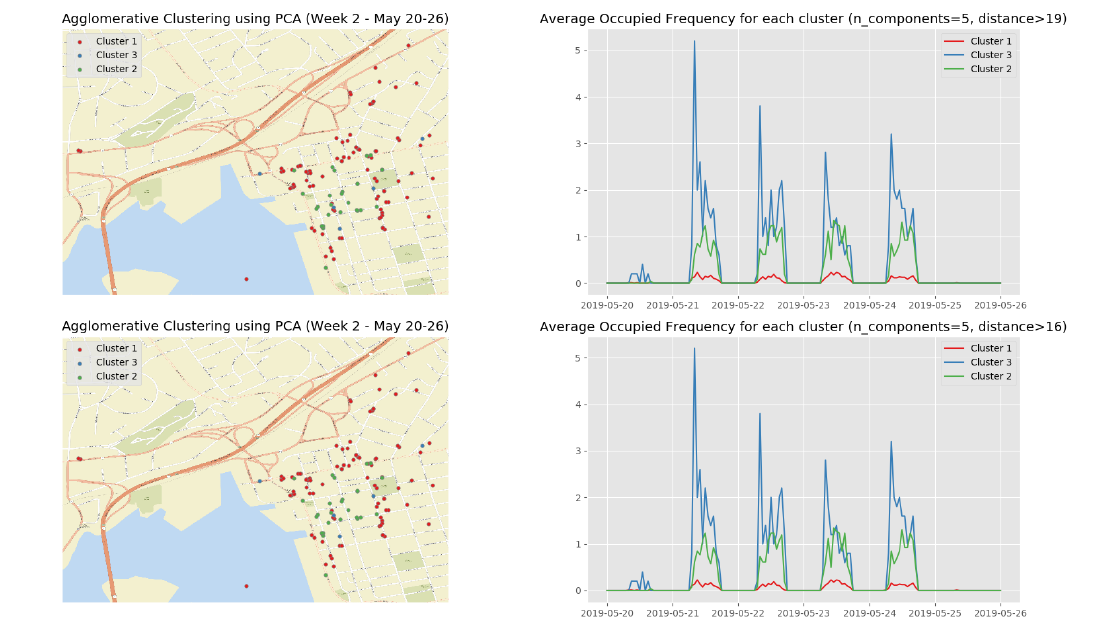
Figure A7. Clustering results using PCA for the 2nd